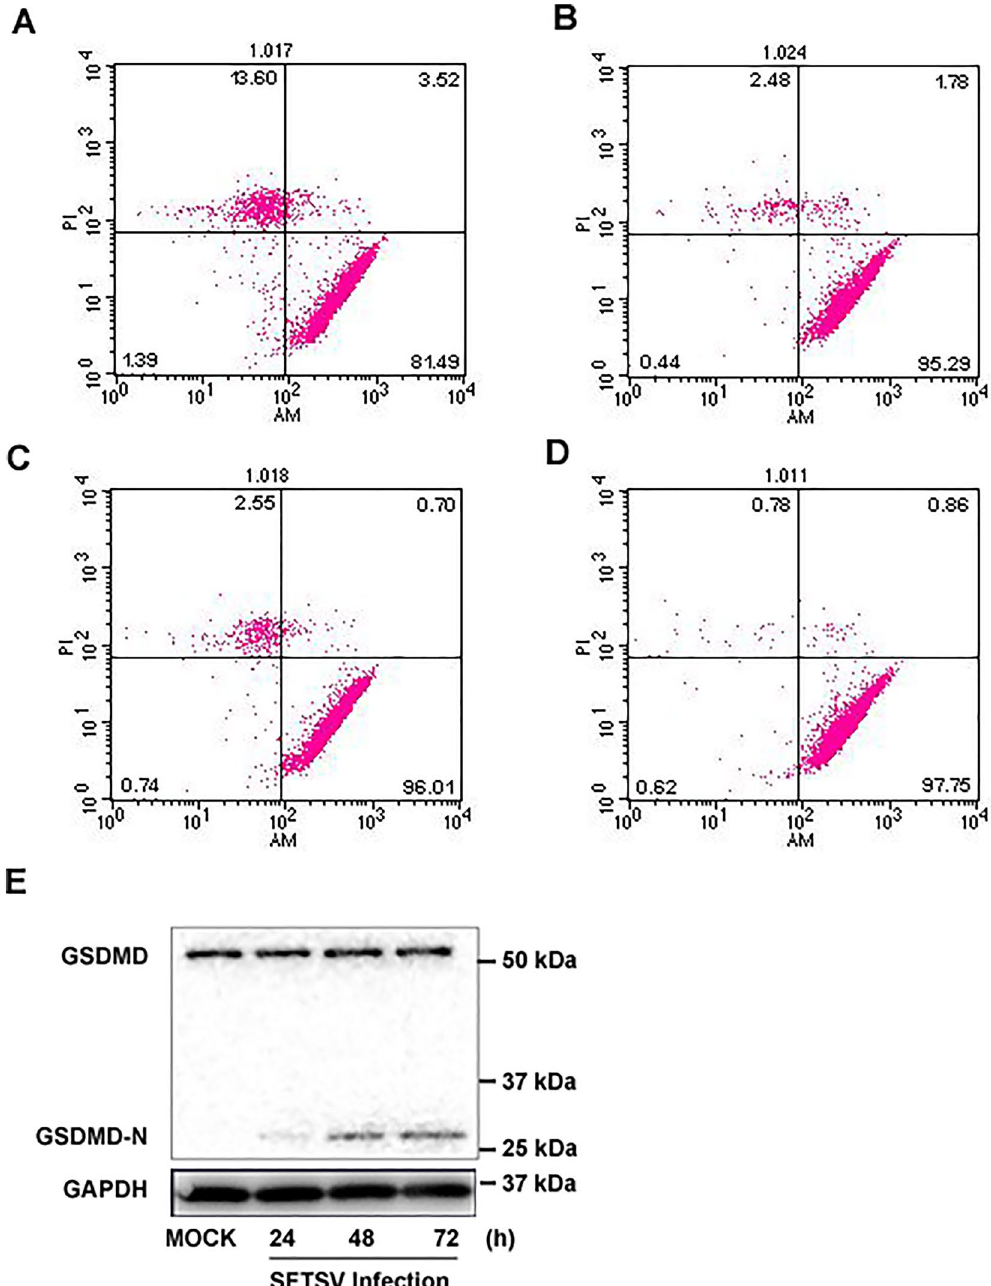
Figure 6. Inhibition of NLRP3 and caspase-1 reduced induction of membrane damage and cell death in PBMCs. PBMCs were pre-treated with DMSO alone, glibenclamide, or Ac-YVAD-cmk for 6 h prior to viral infection at an MOI of 1 for 48 h. The cells were subjected to staining with Calcein-AM/EthD-III for detection of membrane damage and cell death, which were analyzed by Flow cytometry. ( A ) DMSO alone plus SFTSV; ( B ) glibenclamide (1 μM) plus SFTSV; ( C ) Ac-YVAD-cmk (1 μM) plus SFTSV; and ( D ) DMSO. The ratio of membrane damage cells was determined using flow cytometry and differences between groups were analyzed by chi-square test. ( E ) Processing of GSDMD in PBMCs infected with SFTSV. The cells were with SFTSV an MOI of 1 and cell lysates were prepared at various time points p.i. for SDS-PAGE and western blot analysis with antibodies specific for GSDMD and